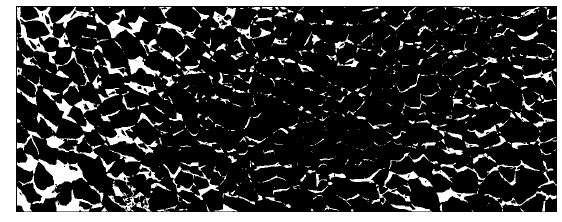
Figure 8: Identification result producing four layers for Figure 7.